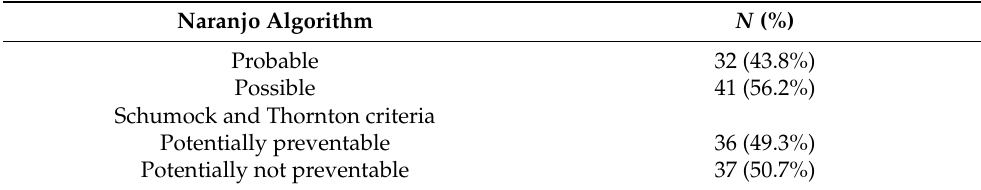
Table 7. DRD causality assessment and